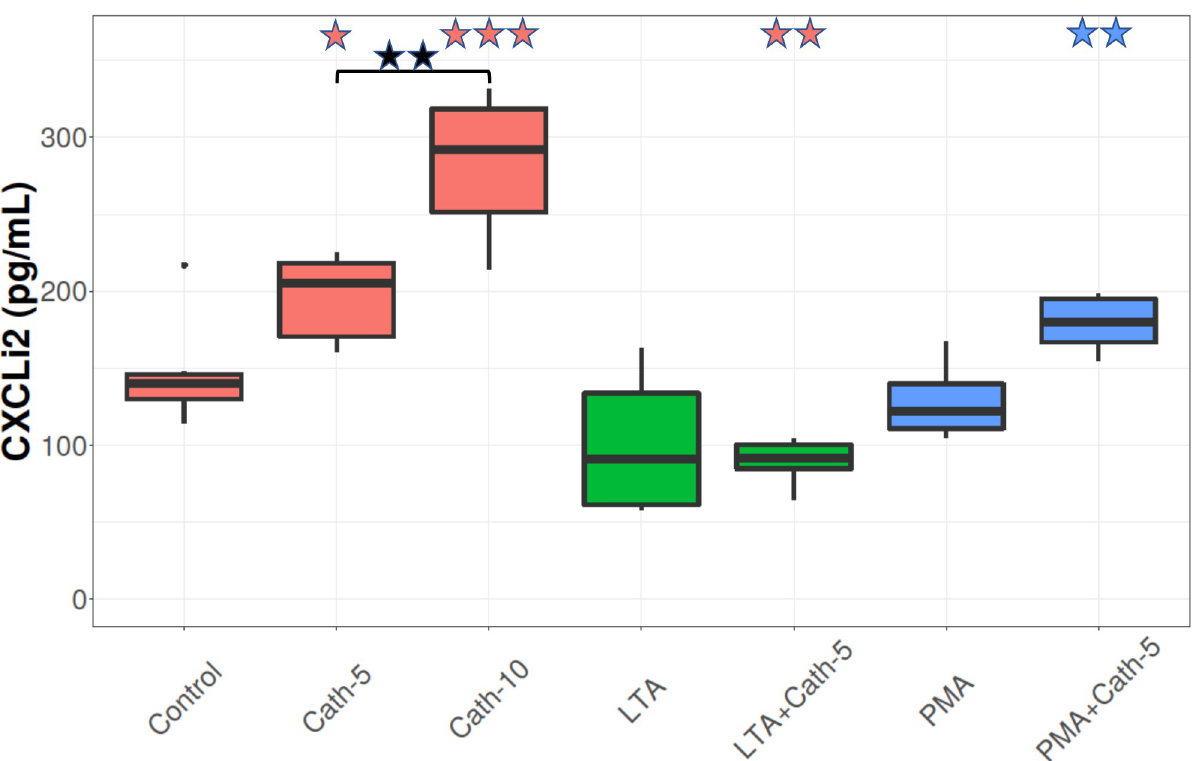
Fig 4. CXCLi2 concentration. Boxplots showing the CXCLi2 concentration for hepatocyte—non-parenchymal cell co-cultures treated with chicken cathelicidin-2 (Cath), lipoteichoic acid (LTA), or phorbol myristate acetate (PMA) only, or the combination of Cath and LTA or PMA (n = 6/group). Results are displayed as pg/mL. Cath-5 = 5 nmol/mL Cath, Cath-10 = 10 nmol/mL Cath, LTA = 50 μ g/mL Staphylococcus aureus LTA, PMA = 1000 ng/mL PMA. The Control refers to absolute control cells that received none of the treatments. Red asterisks over the boxes refer to significant differences compared to control cells, green asterisks to the group treated only with LTA, blue asterisks to the group treated only with PMA, and black asterisks between the two concentrations of Cath. � p < 0.05, �� p < 0.01, ��� p < 0.001.